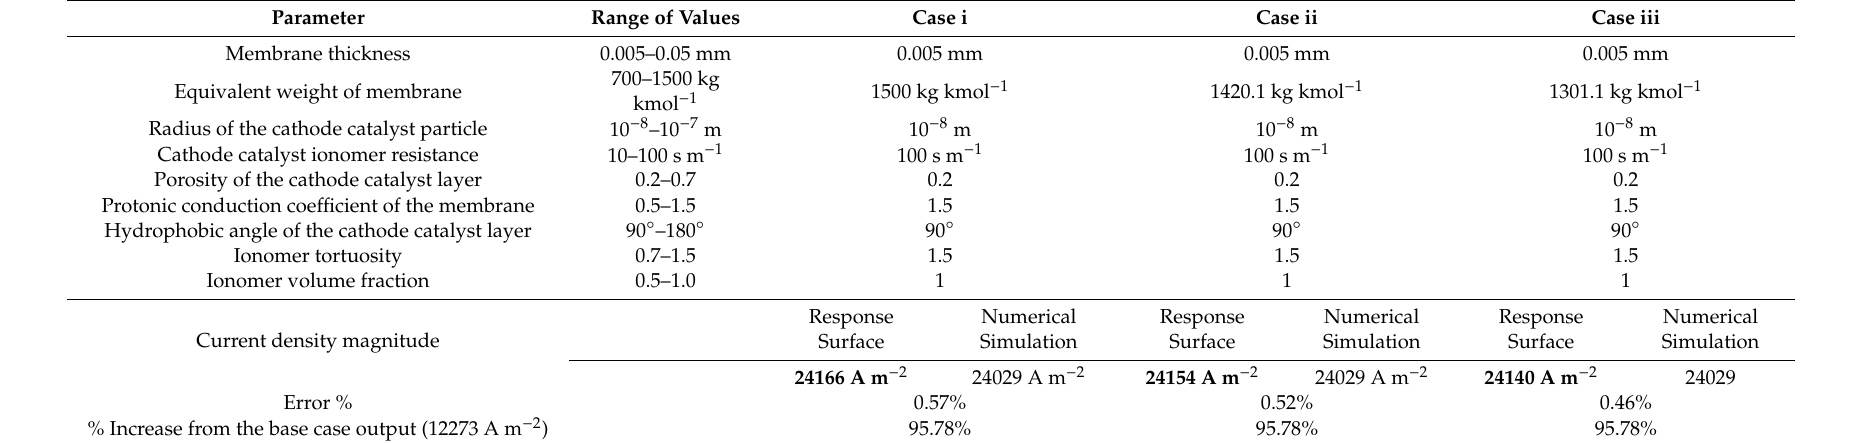
Table 6. Optimization result for three candidate points at 0.6